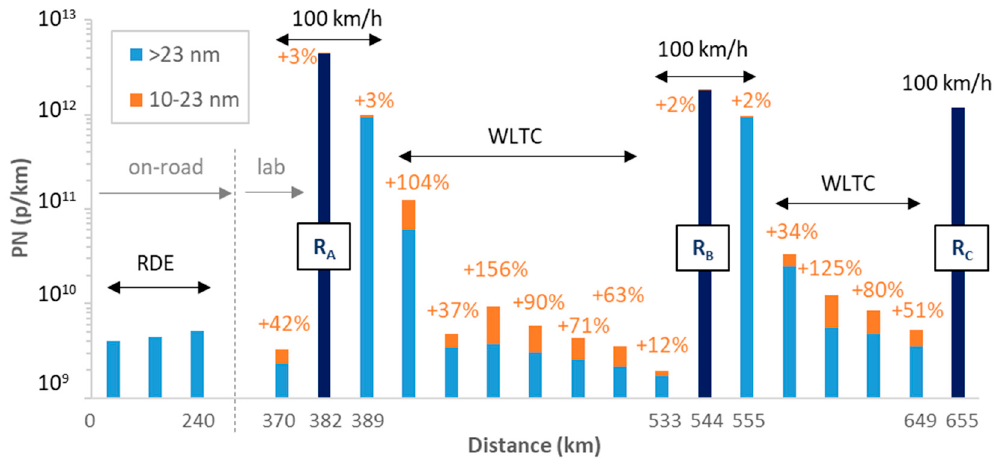
Figure 1. Nonvolatile particle number (PN) emissions > 23 nm and > 10 nm of all tests conducted in this study (on the road and in the laboratory) in the function of the distance driven. Numbers give the distance at the beginning of the respective route or cycle. The percentages give the ratios of the 10–23 nm to the 23 nm concentrations. In dark color with R the regeneration events. Nonvolatile PN laboratory limit for the worldwide harmonized light-duty vehicles test cycle (WLTC) 6 × 10 11 p / km and 1.5 times higher on the road. RDE = real-driving emissions; WLTC = worldwide harmonized light-duty vehicles test cycle.